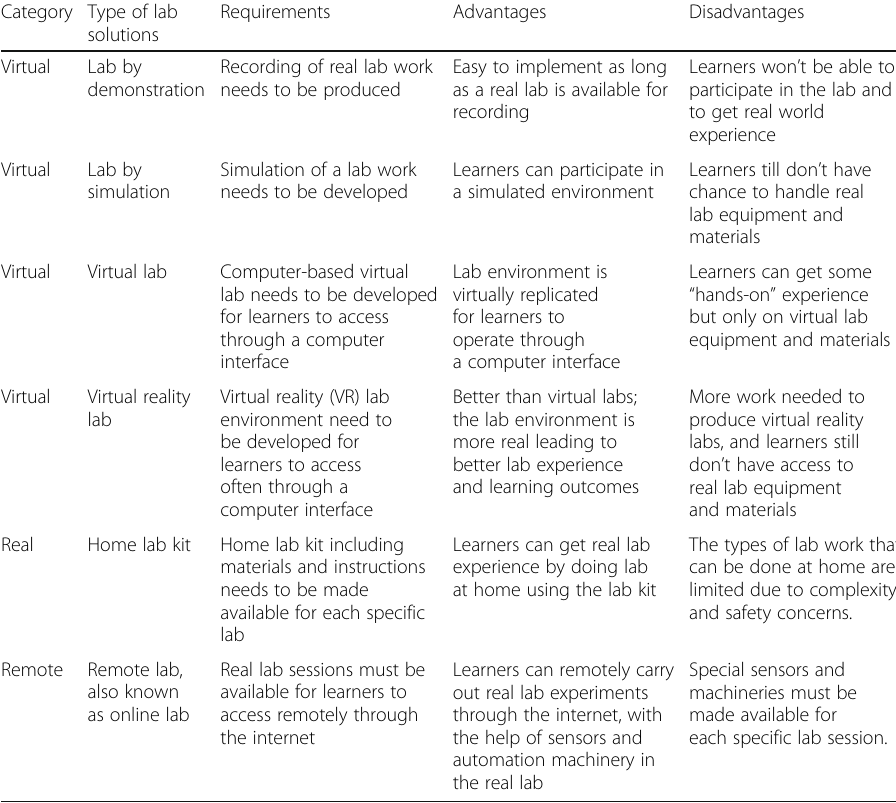
Table 1 Summary of existing lab solutions used in distance education Category Type of lab